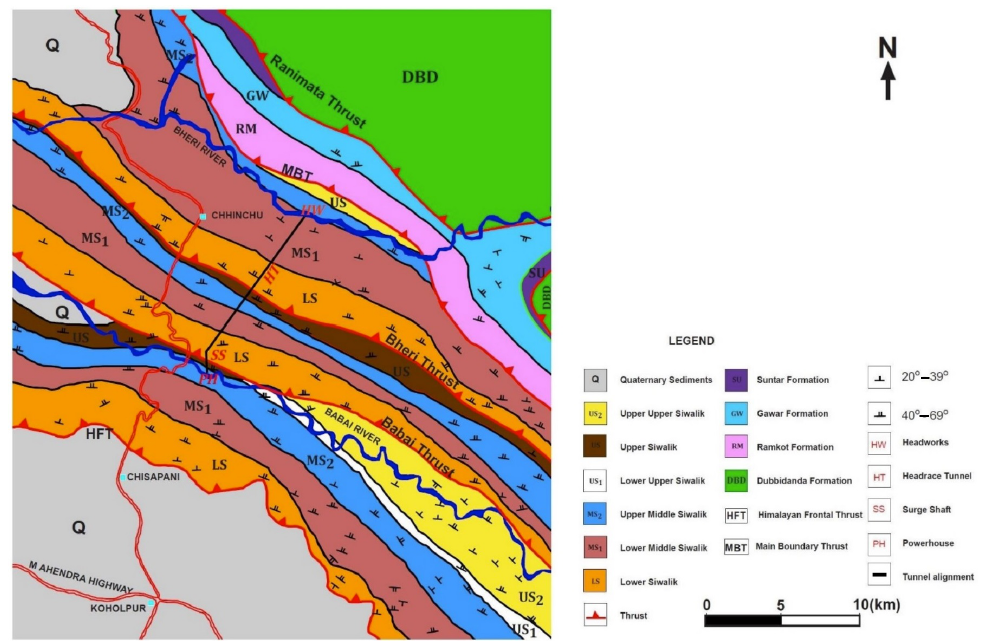
Figure 9. Geological map of the (BBDMP) project area, modified after DMG